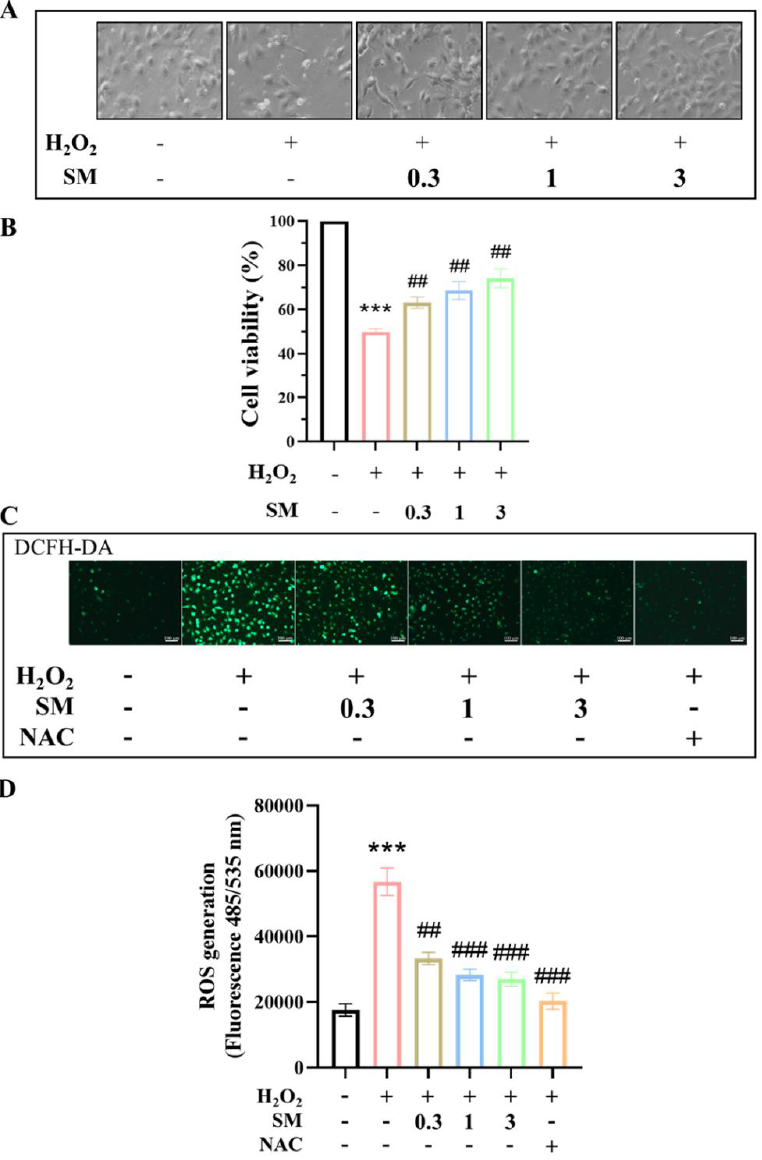
Figure 3. Effect of SM on the viability and intracellular ROS production of H 2 O 2 -treated human aortic endothelial cells (HAECs). ( A ) Representative images showing the effect of SM (0.3–3 µM) on HAEC morphological injury induced by H 2 O 2 observed under a light microscope. ( B ) Following pretreatment with different concentrations of SM (0.3–3 μM) for 1 h, HAECs were treated with H 2 O 2 (100 μM) for another 24 h; cell viability increased in a dose-dependent manner following SM treatment. Cell viability was determined using MTT assay. ( C ) A typical fluorescence image captured using a fluorescence microscope using 2′,7′-dichlorofluorescein diacetate to stain HAECs after H 2 O 2 stimulation and SM incubation to observe intracellular ROS intensity; scale bar = 100 μm. ( D ) Cellular ROS/superoxide detection assay was performed. Data are presented as mean ± SEM. p values were determined using Student’s t -test. (*** p < 0.001 vs. control group, ## p < 0.01, ### p < 0.001 vs. H 2 O 2 group). N -acetyl- L -cysteine (NAC, 3 mM). To elucidate whether SM suppresses H 2 O 2 -induced apoptosis in HAECs, cells were pretreated with increasing concentrations of SM (0.3–3 μM) and then exposed to H 2 O 2 (100